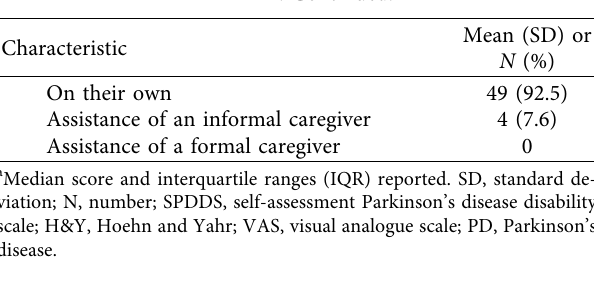
Table 1: Characteristics of the sample ( n �